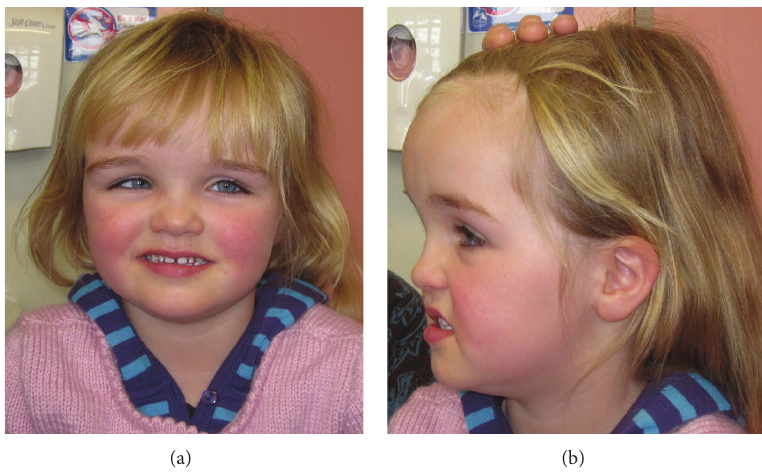
Figure 1: (a) Image of Patient 2. (b) Patient 2 exhibits frontal bossing and macrocephaly.